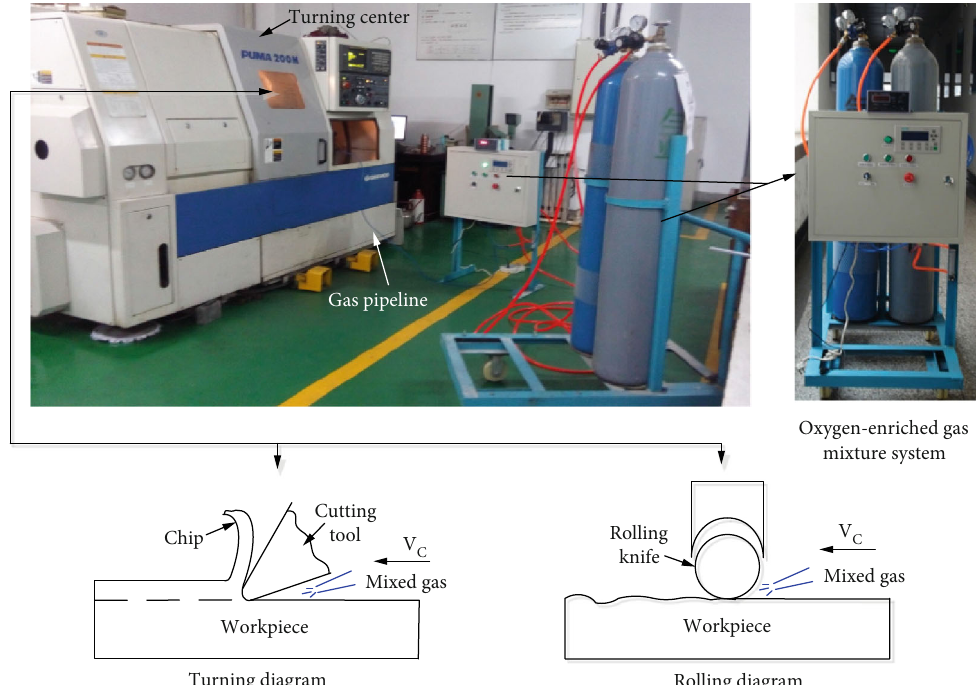
Figure 2: Experimental device for turning and rolling in an oxygen-enriched atmosphere.